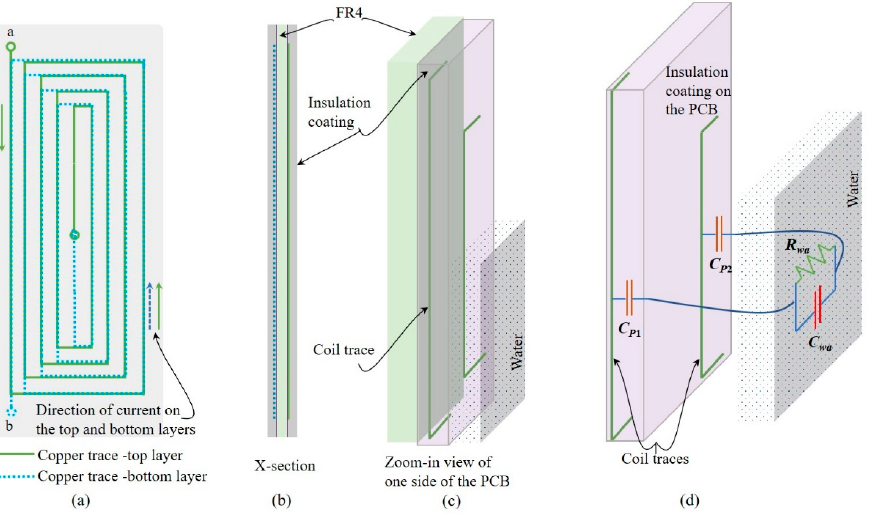
Figure 9. Details of the planar coil: ( a ) the direction of current in the coil; ( b , c ) views of the PCB. It is a two-layer PCB. The terminals of the coils are marked as ‘a’ and ‘b’. The traces are insulated and hence do not have direct contact to water. ( d ) Water column impedance and capacitance between the traces.